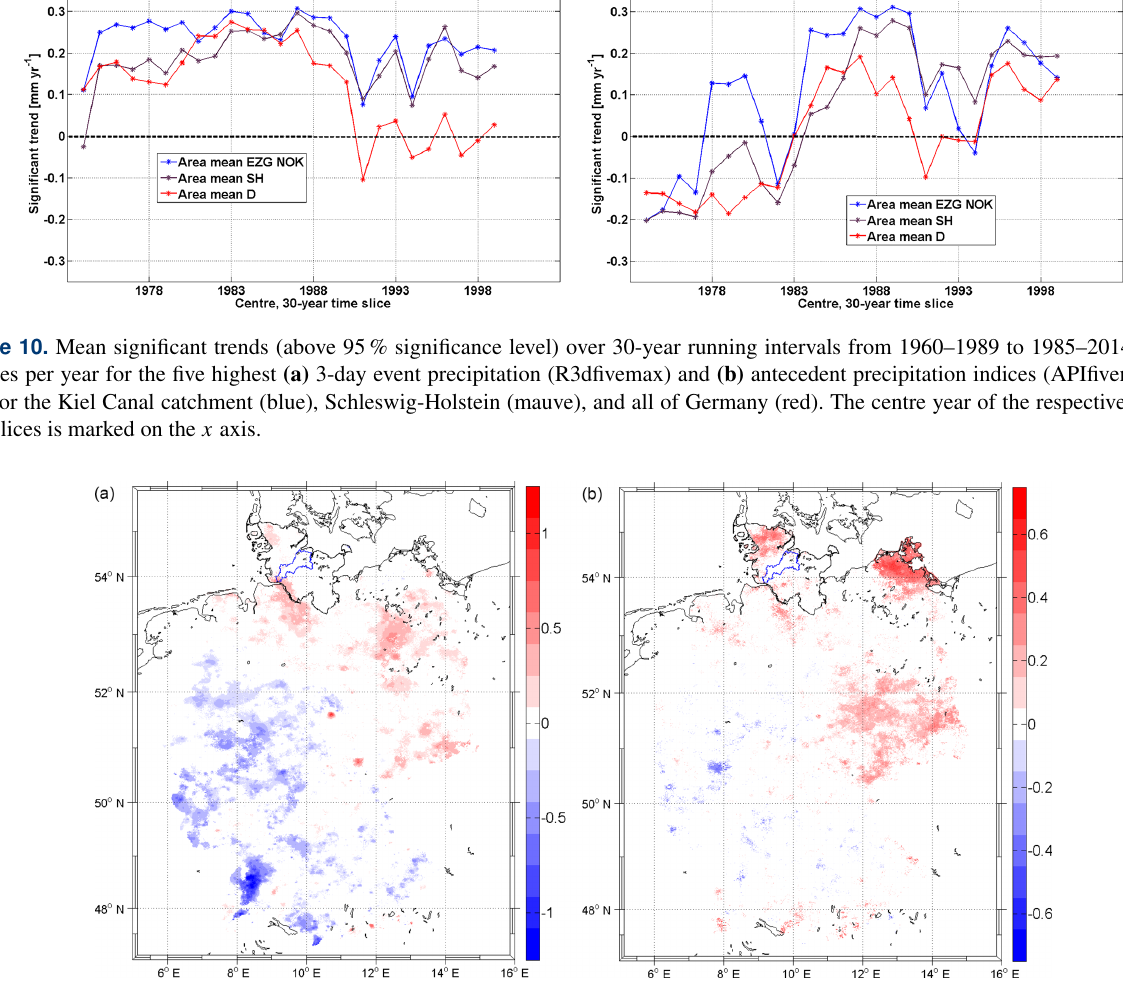
Figure 11. Significant trends (above 95% significance level) in millimetres per year for the five highest (a) 3-day event precipitation (R3dfivemax) and (b) antecedent precipitation indices (APIfivemax) per year in Germany; base period 1983–2012. The boundaries of Schleswig-Holstein are marked in black, boundaries of the Kiel Canal catchment in